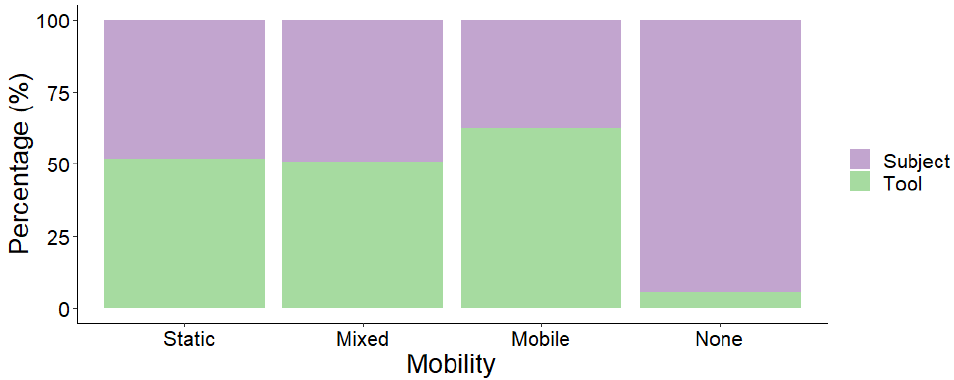
Figure 28. Deployment distribution between node mobility and deployment